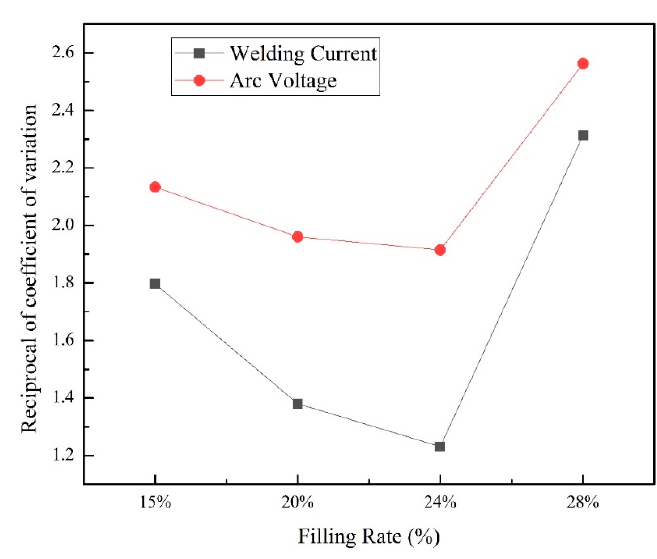
ffi cient at di ff erent filling Figure 4. Reciprocal of variation coefficient at different filling rate. Figure 4. Reciprocal of variation coe Figure 4. Reciprocal of variation coefficient at different filling rate.